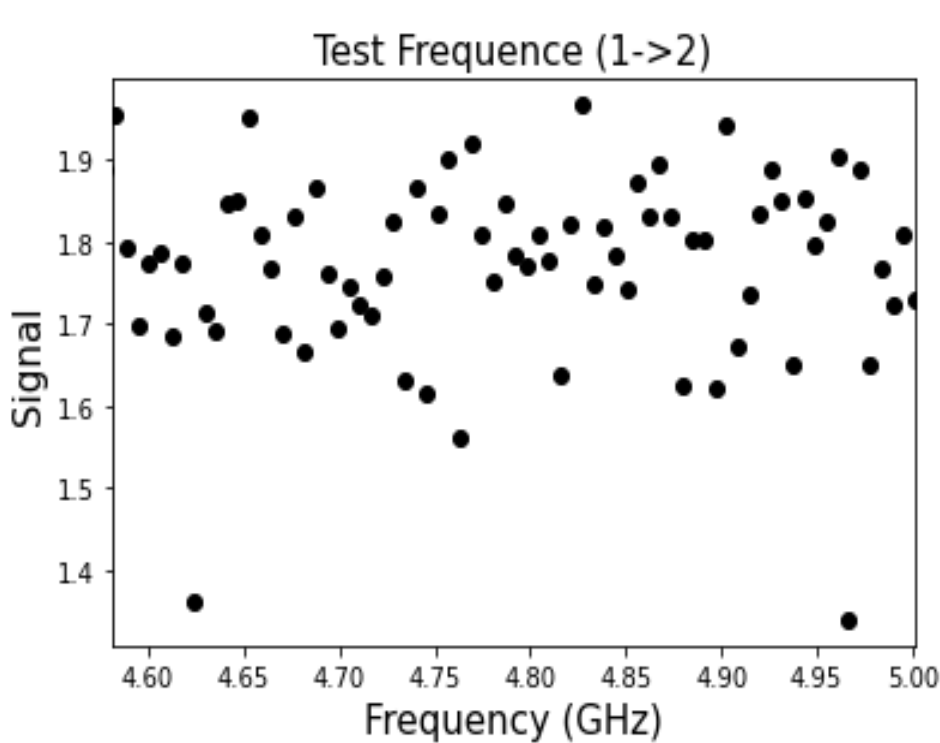
Figure 5. Main and sideband pulse for sweeping for the 1 → 2 transition frequency.